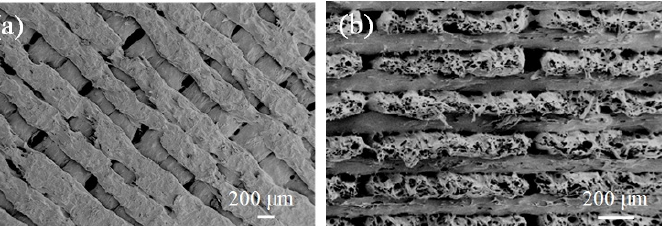
Figure 5. ( a ) SEM micrographs of the specimen surface after shear failure, ( b ) SEM micrographs of the cross section of the specimen with 0 fiber content after shear failure.